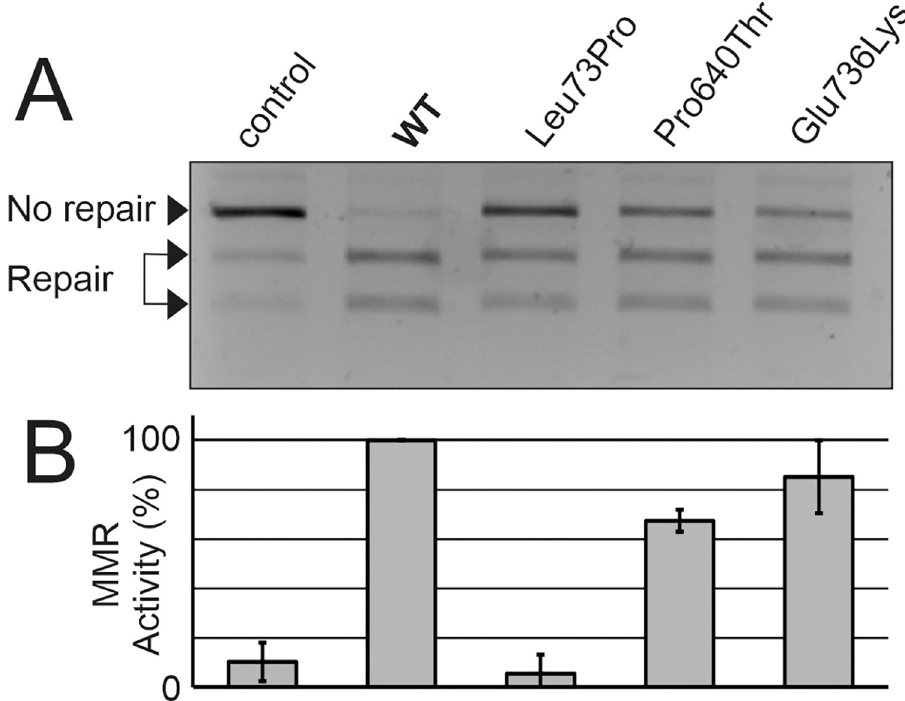
Fig 3. Analysis of mismatch repair activity of the MLH1 variants. DNA mismatch repair activity was assessed for wild-type and variant MLH1 proteins, and a negative control (without MLH1 protein) was included as detailed in “Materials and Methods”. A , Representative agarose gel image of the MMR activity measurement. The extent of repair is visible in the agarose gel electrophoresis by the generation of 2 smaller fragments (“Repair”) of the unrepaired, linearized plasmid (“No repair”). The shown agarose gel is cropped, a full view of the gel is provided in the supplementary data. B , 4 independent experiments were performed, and repair activity was scored relative to wild-type MLH1 protein (100%). Average repair values and standard deviations are